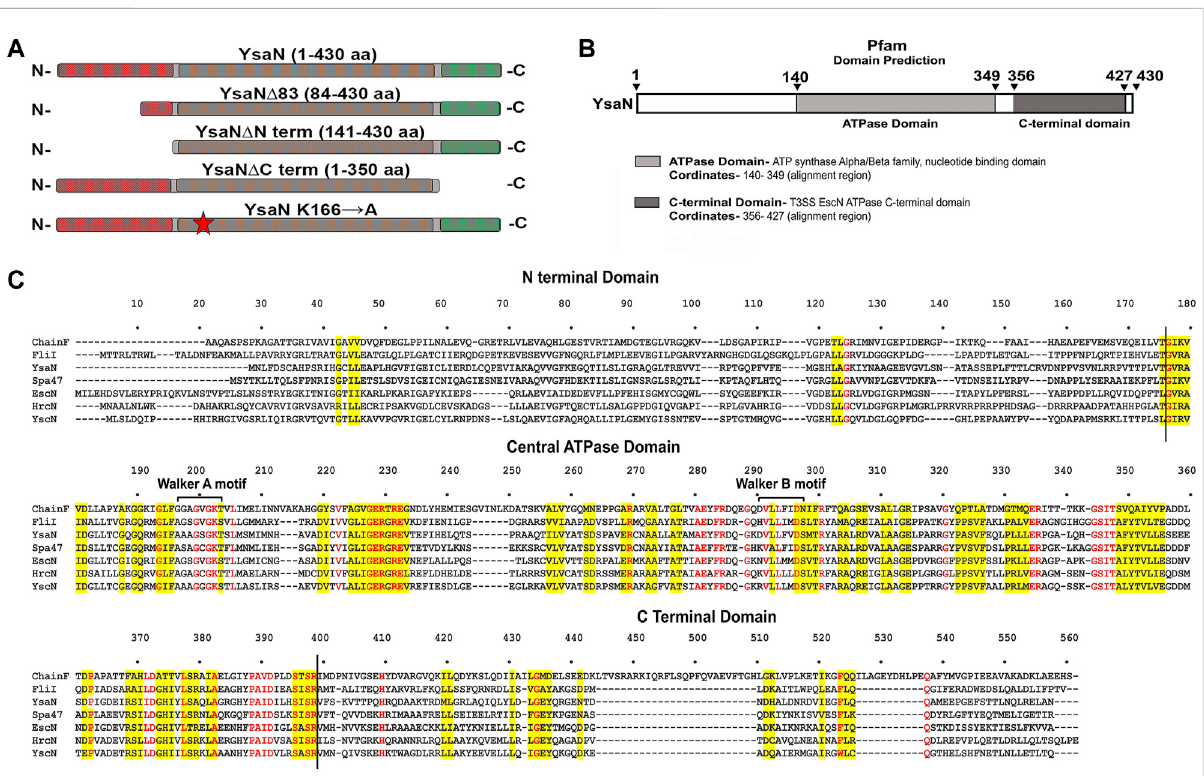
FIGURE 1 Bioinformatic analysis of YsaN- (A) , Linear representation of the YsaN constructs used in this study (based on domain analysis of YsaN using Pfam, also refer to Table 1 for complete details) Different color shading represents respective domains of YsaN, Red- represents N terminal domain, Gray- represents acentral domain, and green- represents C-terminal domain. The red star shows site-directed mutationsiteon thecentral domain. (B) , Pfam Domain analysis of YsaN sequence. (C) , Multiple sequence alignment of YsaN and homologs (also refer to Supplementary Tables S2 – S4for details).Thevertical blackline representsthedomain partition (i.e., N-terminal andC-terminaldomains)ofYsaN sequence basedonPfam domain